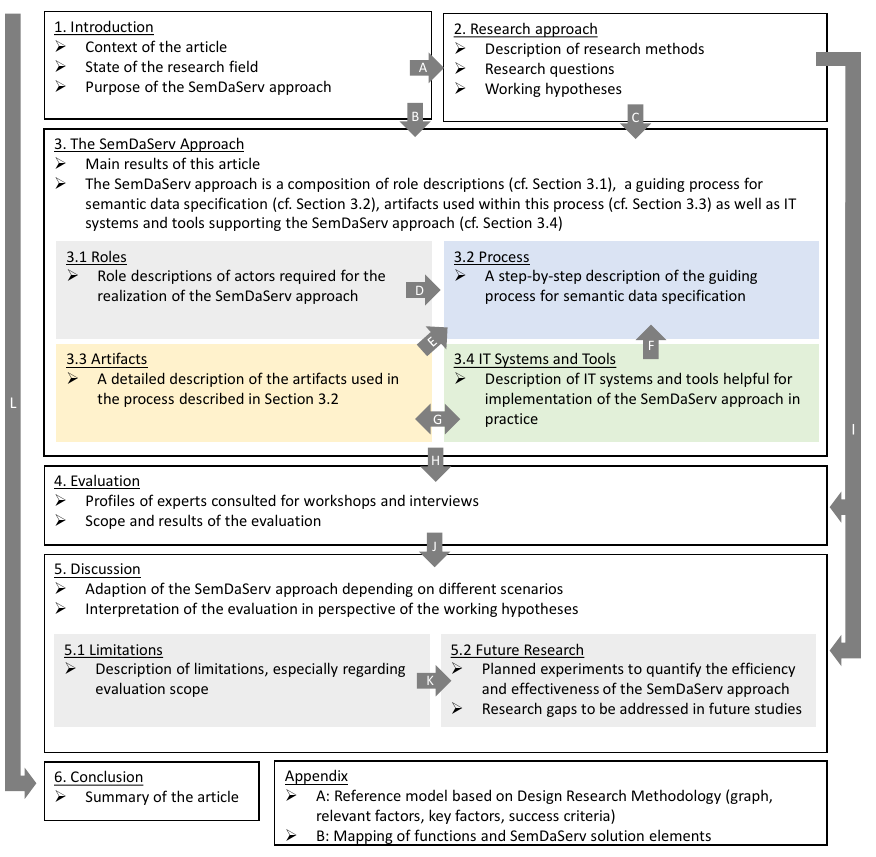
Figure 1. The structure of the